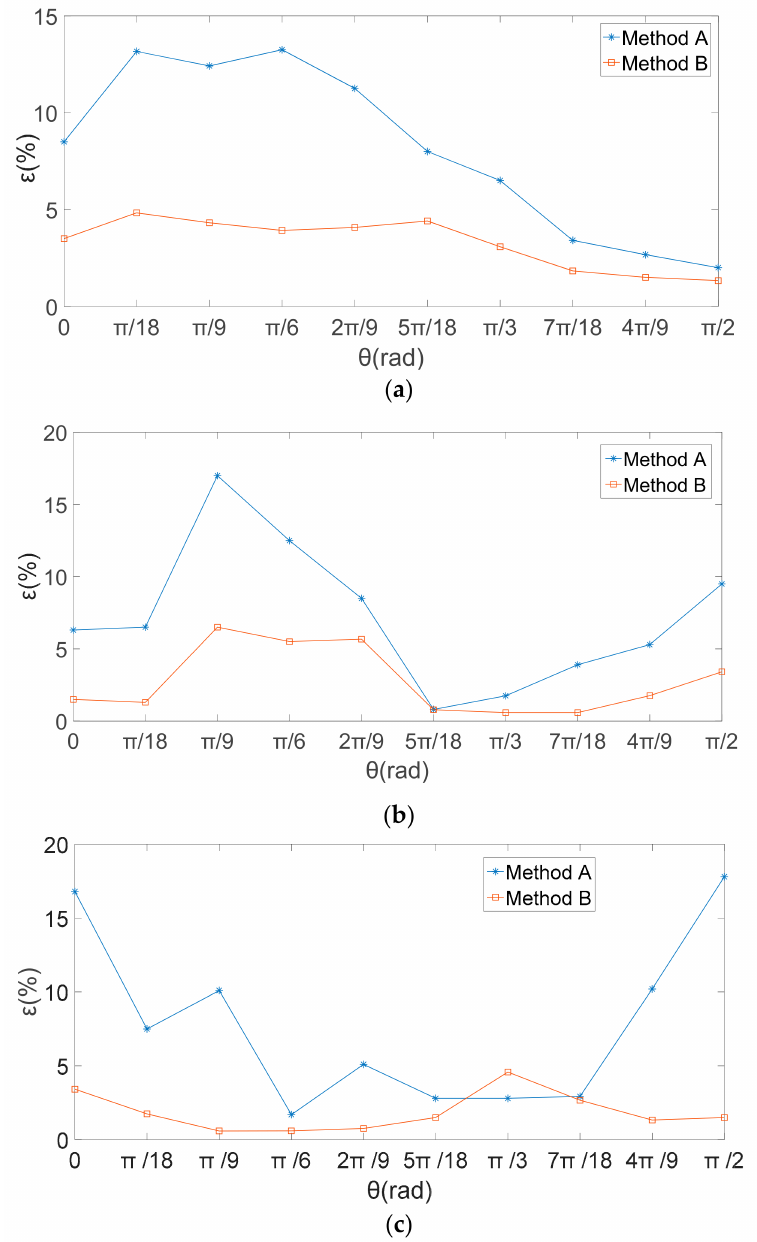
Figure 9. Relative Error in Electric field intensity ( ε /%). ( a ) X axis direction; ( b ) Y axis direction; ( c ) Z axis